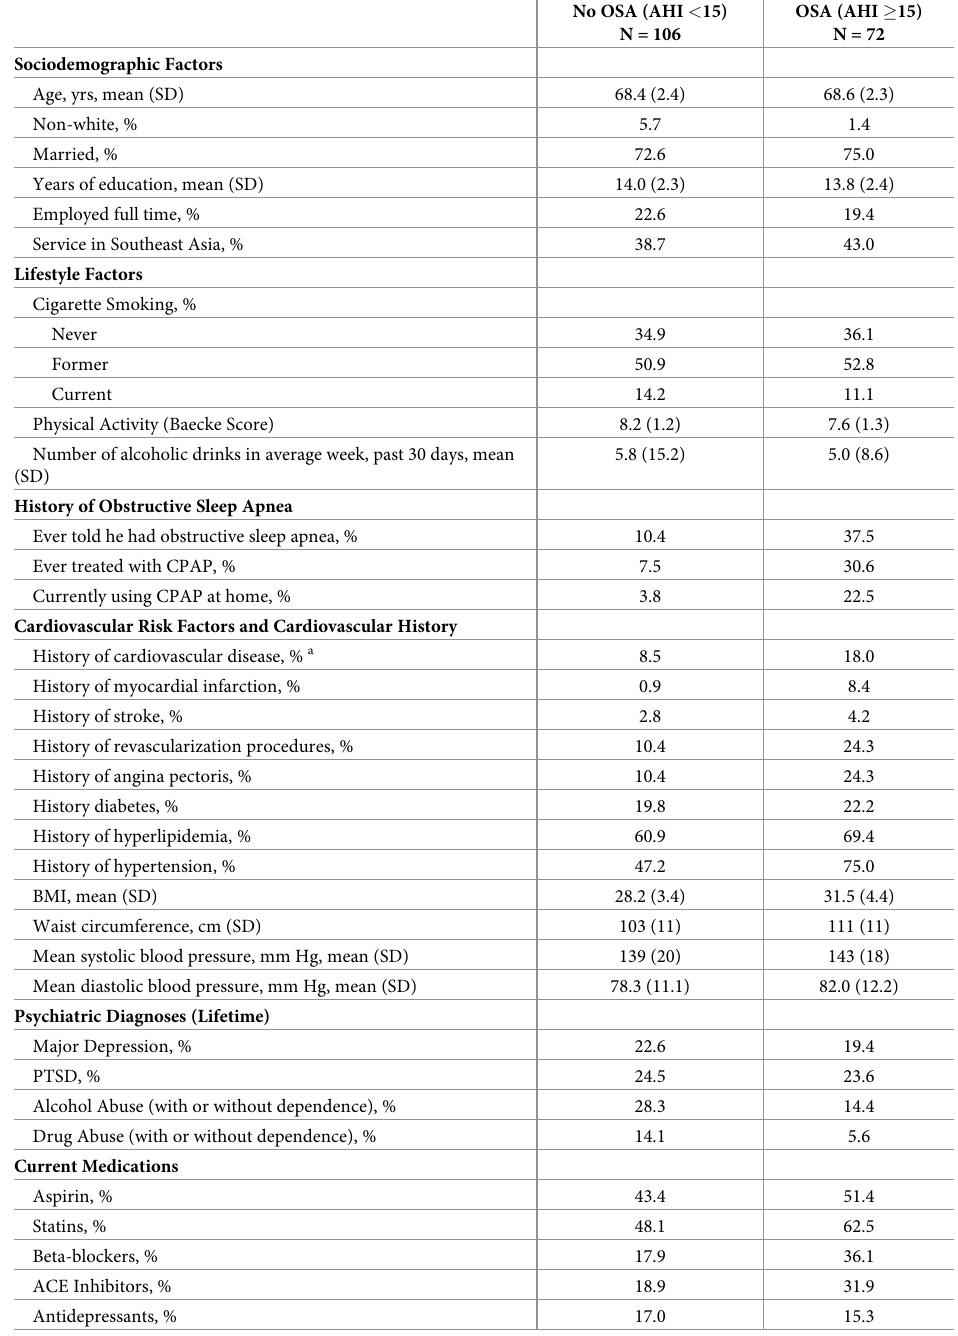
Table 1. Sociodemographic factors, military service, lifestyle, and cardiovascular disease risk factors in twins with and without obstructive sleep